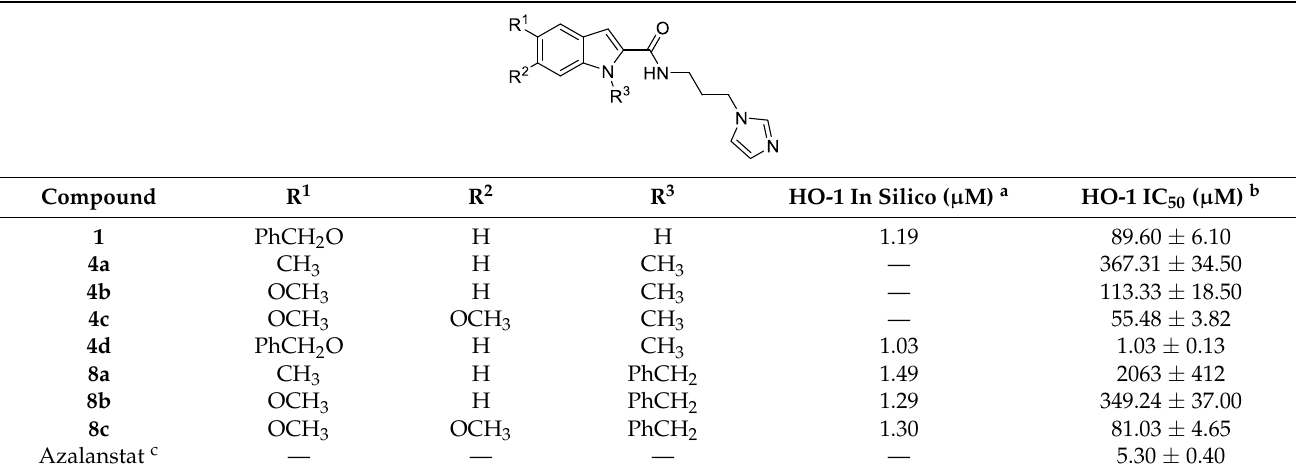
a In silico average calculated activity for the virtually evaluated compounds ( K IC 50 values in µ M ± standard deviation (SD) and are the mean of triplicate experiments. c Data taken from ref.